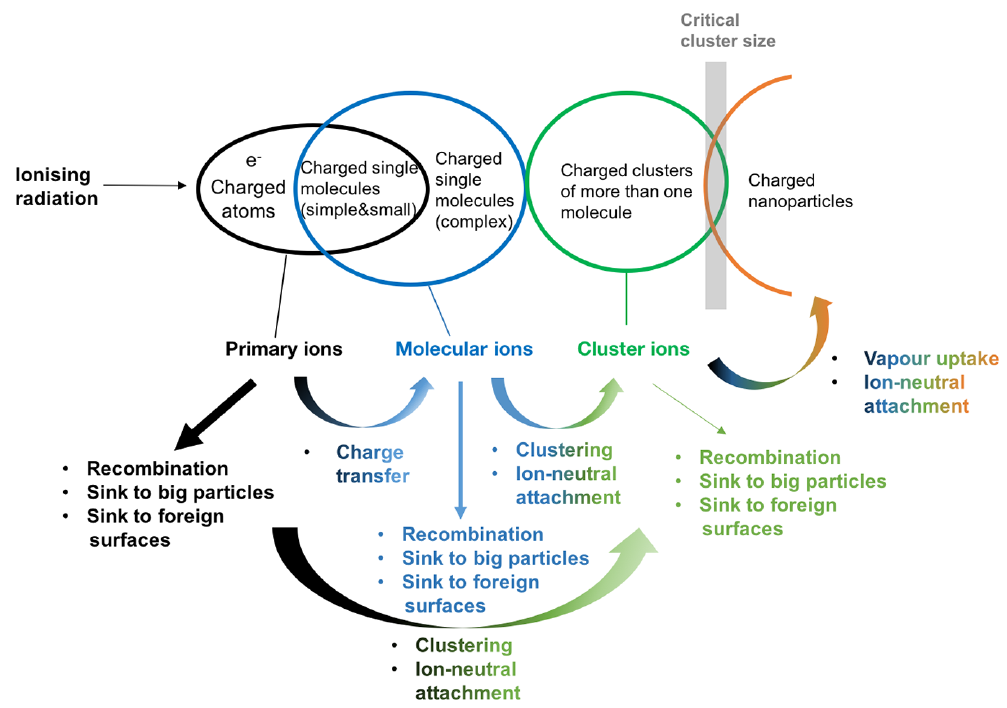
Figure 1. A schematic demonstration of the relationship between primary ions, molecular ions and cluster ions, as well as processes governing their formation and